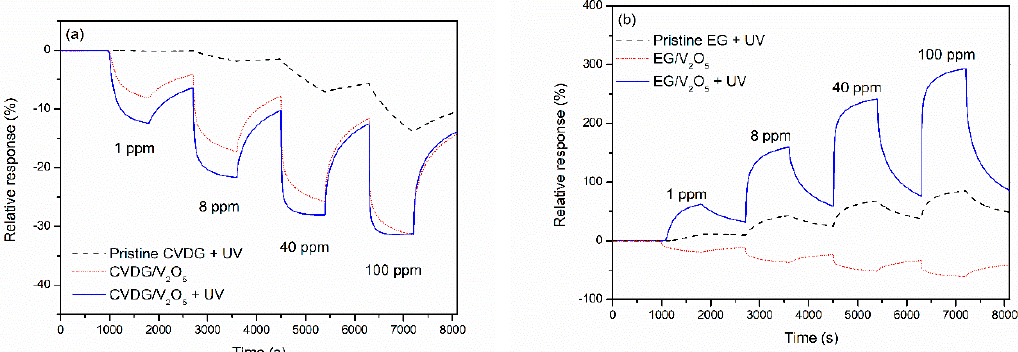
Figure 4. Electric conduction response of sensors based on V 2 O 5 functionalised ( a ) CVD graphene on Si/SiO 2 , and ( b ) EG on SiC, to varying NH 3 concentrations at the room temperature. Results for pristine graphene are shown as a reference. Permanent UV light was on during the measurements, except for a single dark run shown for comparison. Relative humidity was 20%. All time intervals of gas exposure and recovery are 900 s.